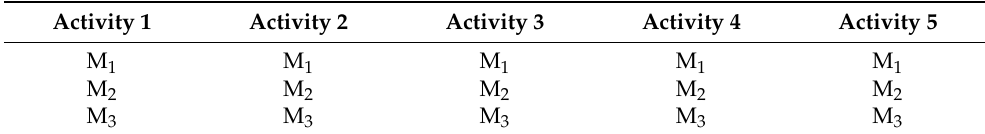
Table 7. All possible activities for five months.